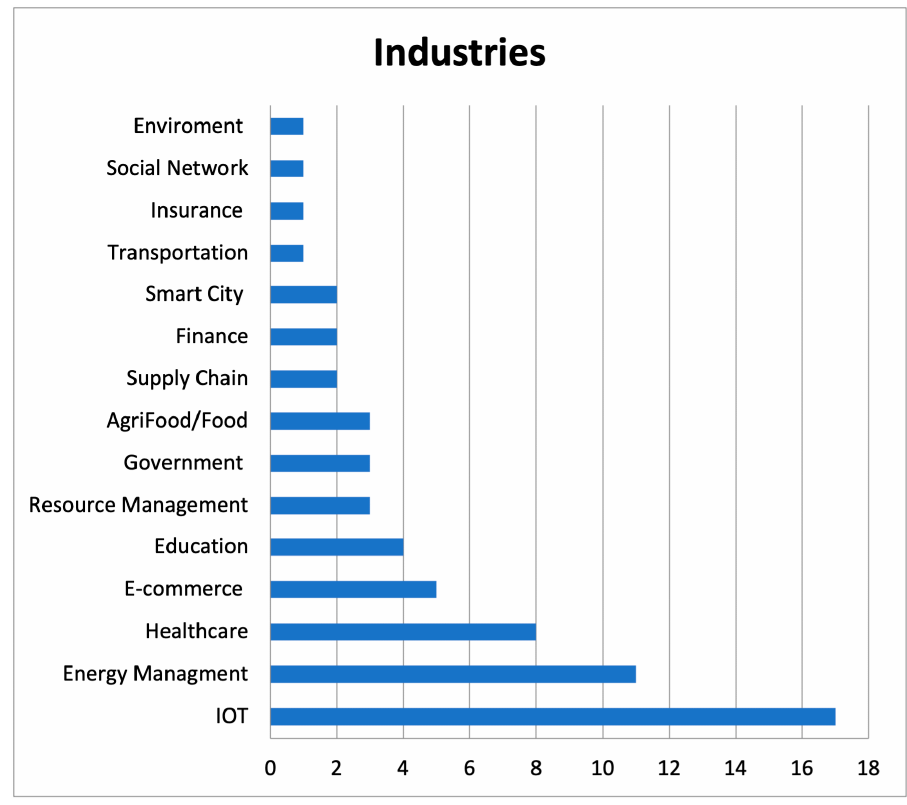
Figure 7. Blockchain application domain per selected papers.